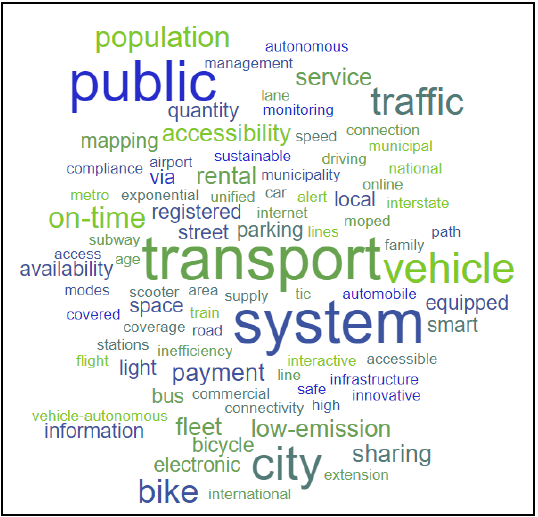
Figure 17. Most frequent indicators within the theme of “mobility”.